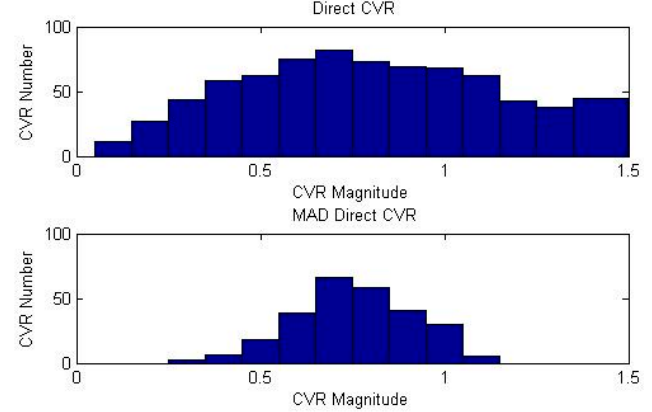
Figure 11. Distribution of the CVR factors estimated at the Bookgong D/L.